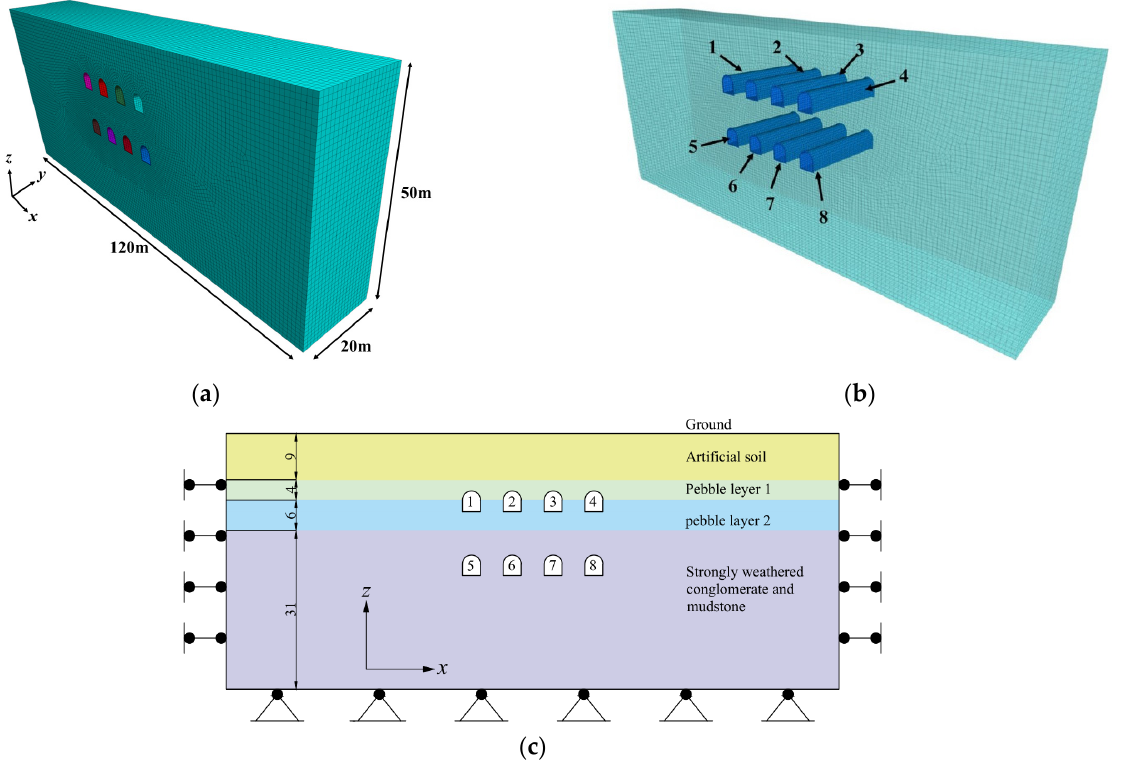
Figure 2. Model for numerical simulation: ( a ) numerical model, ( b ) primary linings of the pilot tun- nels and ( c ) boundary condition of the numerical model (unit: m). Table 1. Parameters of the soil mass and primary lining. Table 1. Parameters of the soil mass and primary